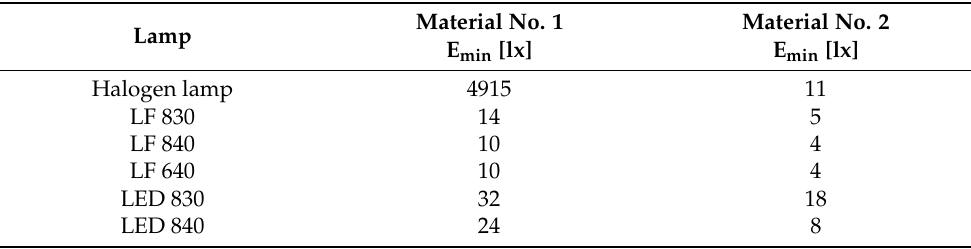
Table 3. The minimum values of illuminance on the surfaces of the tested materials allowing them to fulfil the requirements of the standard [2].